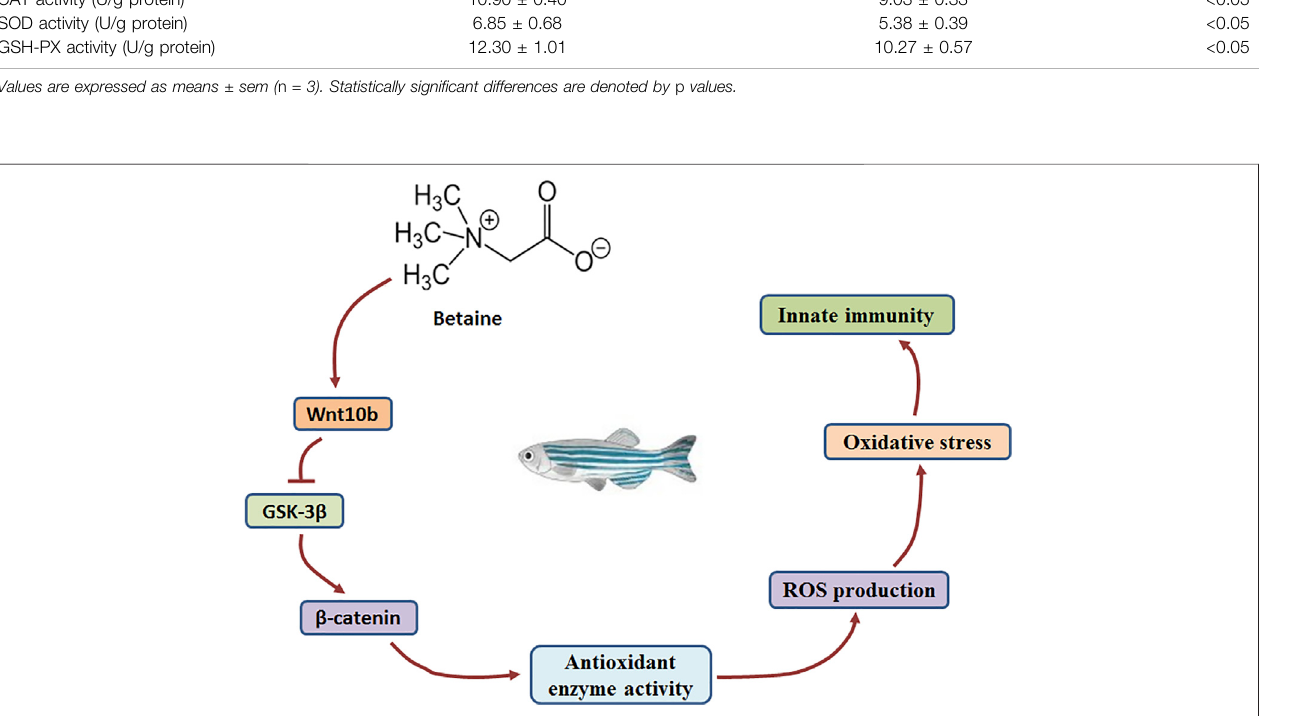
Frontiers in Physiology |